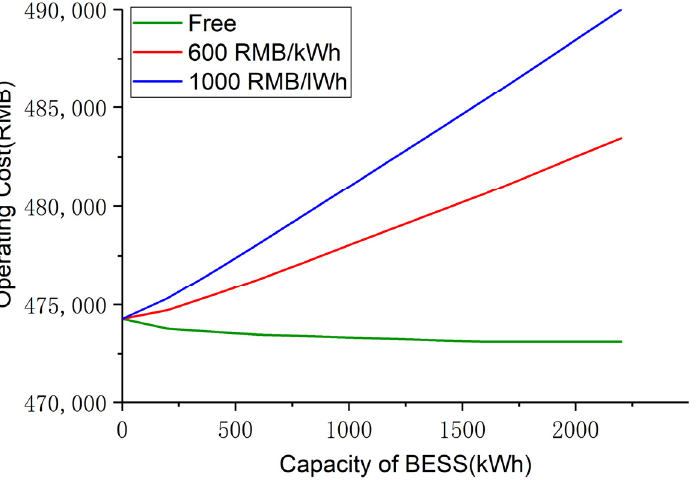
Figure 17. Optimal operating costs of the BESS given different capacity and price of unit capacity.